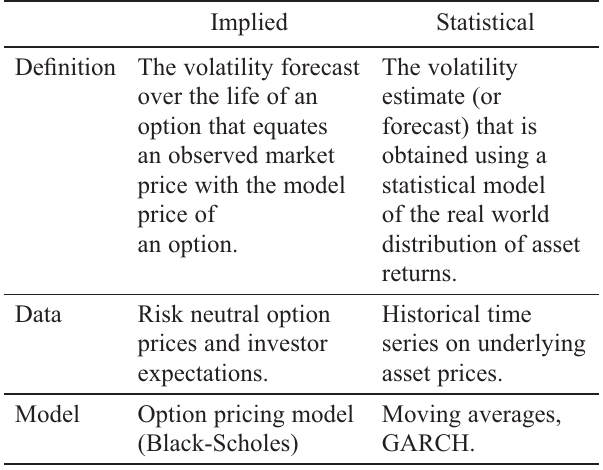
Table 1. Comparison of implied and statistical